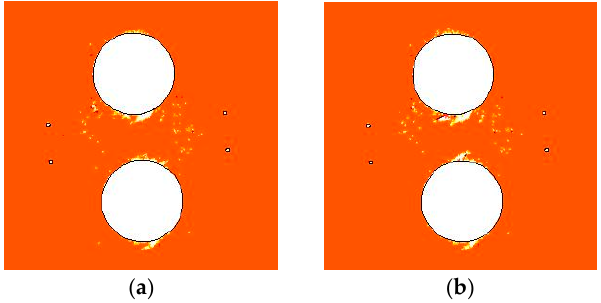
Figure 16. Damage zone distribution at 60 days of heating stage: ( a ) α = 0; ( b ) α = 0.5.